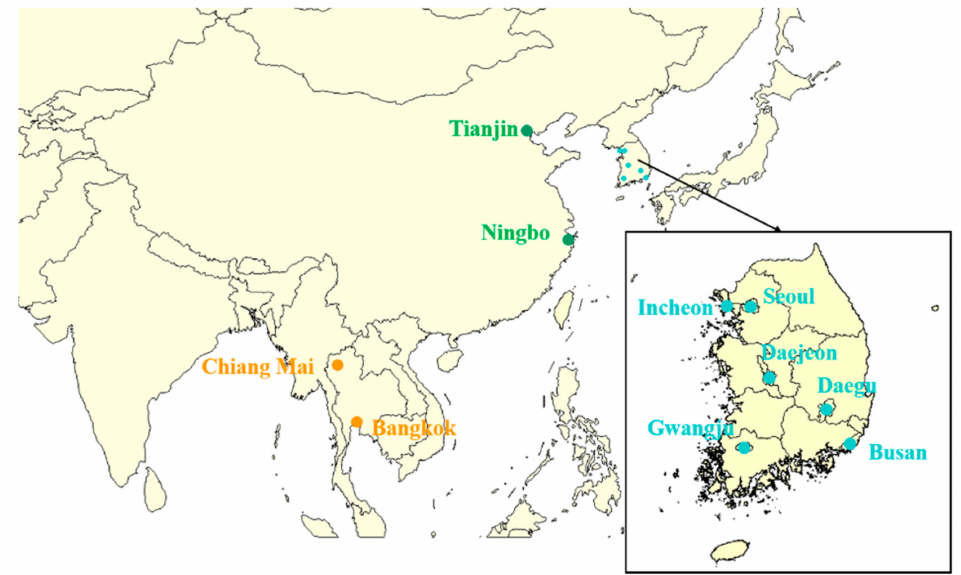
Figure 1. The locations of 10 Asian cities in this